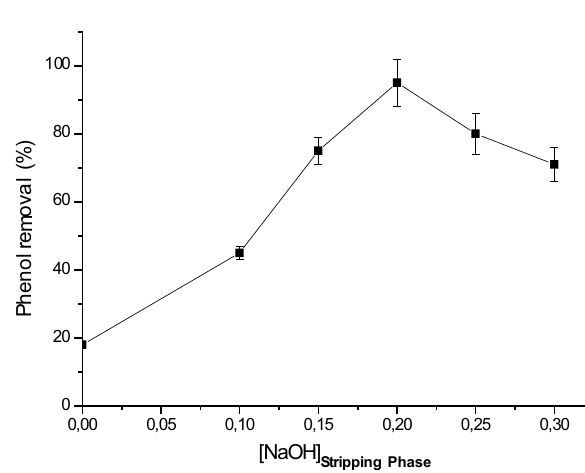
Fig. 6 Effect of NaOH concentration in stripping phase on